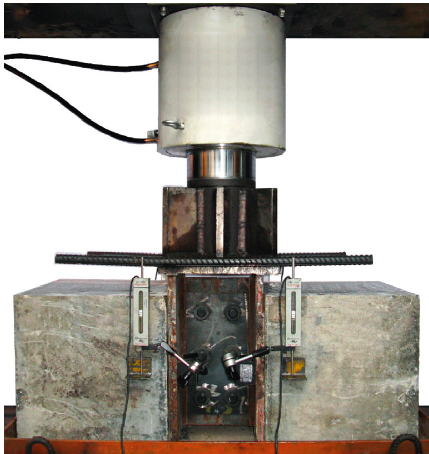
Figure 2: Test setup and